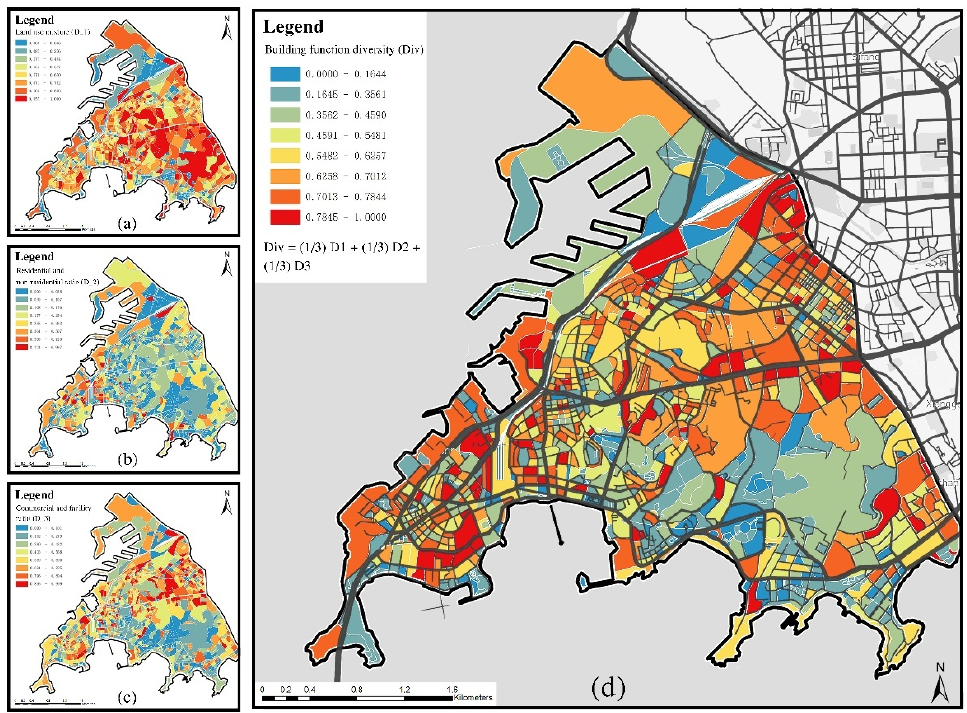
Figure 4. Building function diversity analysis. ( a ) Land use mix. ( b ) Residential and non-residential ratio. ( c ) Commercial and facility ratio. ( d ) Building function diversity composite index.